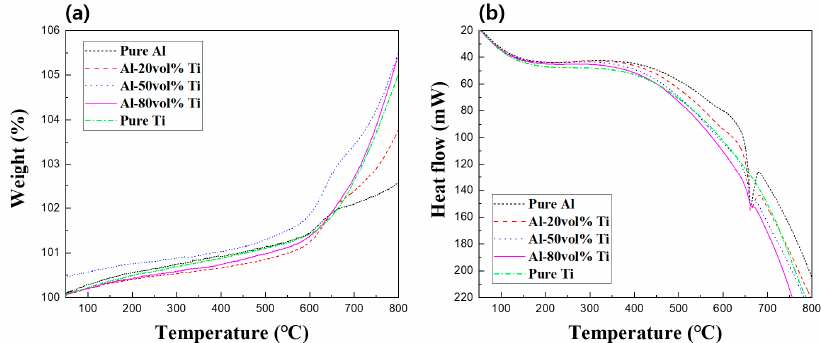
Figure 6. ( a ) Thermogravimetric analysis (TGA) and ( b ) differential thermal analysis (DTA) curves of pure Al, Ti, and Al-20, 50, and 80 vol.% Ti powders.